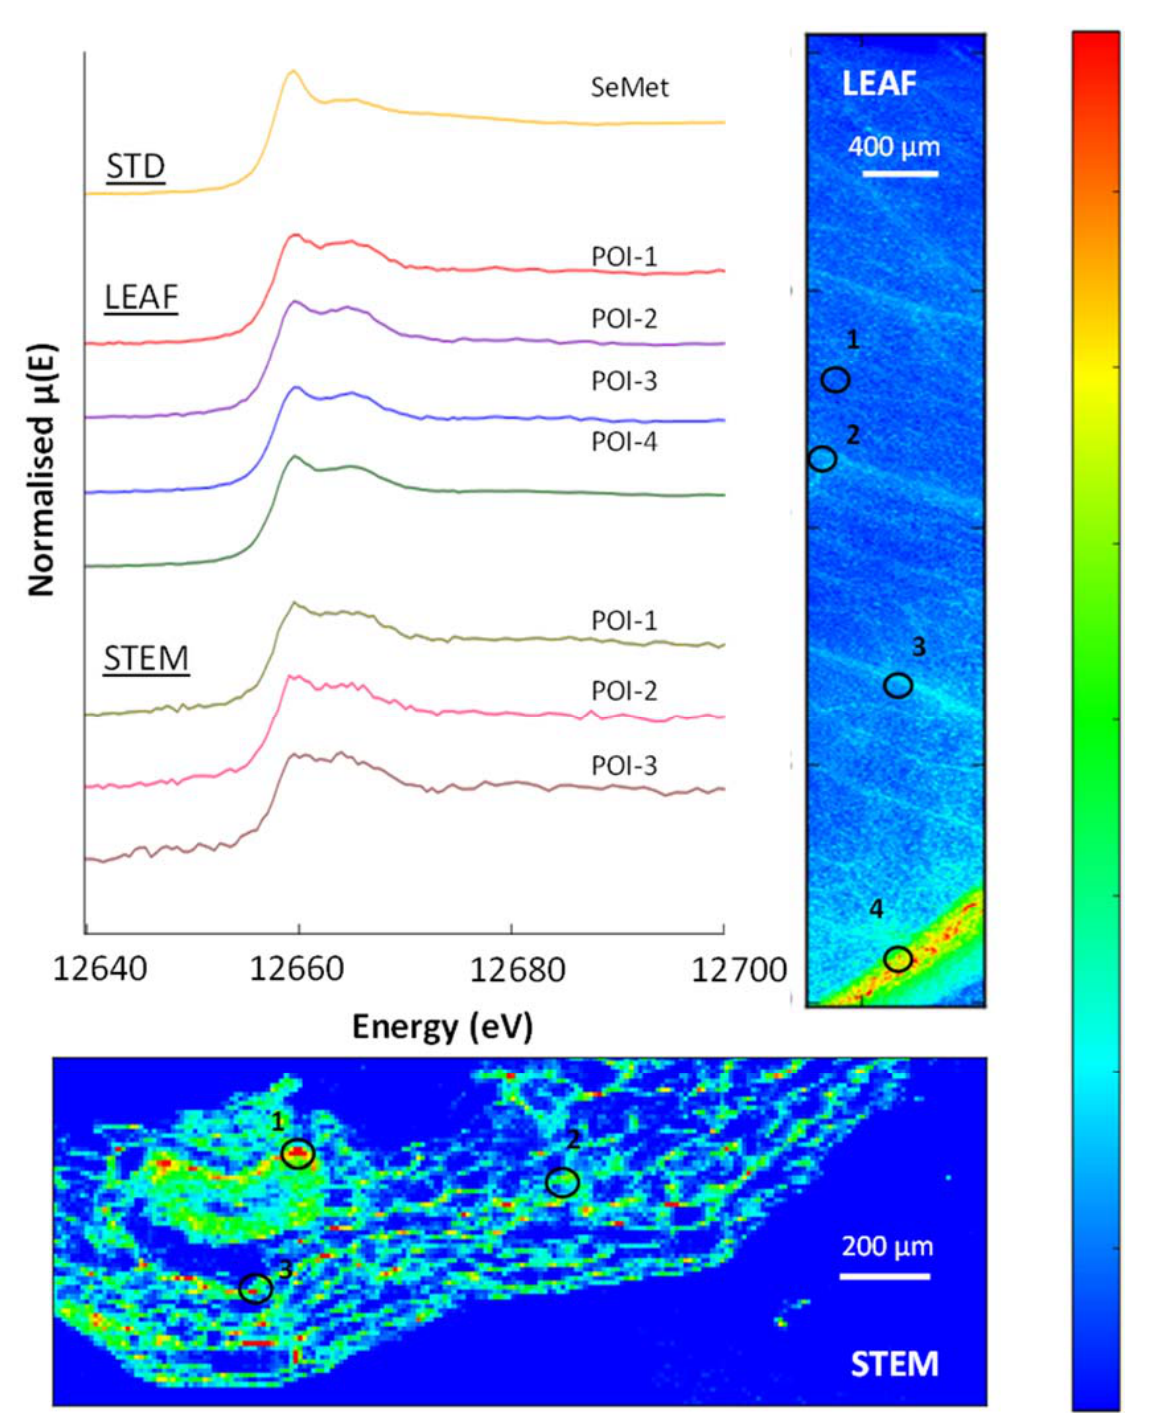
Figure 8. µ -XRF Se K -edge maps showing a white clover leaf and a cross-section through a stem and Figure 8. μ ‐ XRF Se K ‐ edge maps showing a white clover leaf and a cross ‐ section through a stem and a leaf from the vein out towards the margin. The µ -XRF is on a pseudo-temperature scale, with high a leaf from the vein out towards the margin. The μ ‐ XRF is on a pseudo ‐ temperature scale, with high selenium counts in red and areas with no counts in dark blue. ( Top left ): normalised XANES spectra selenium counts in red and areas with no counts in dark blue. Top left: normalised XANES spectra showing selenium species in selected POIs and the SeMet showing selenium species in selected POIs and the SeMet standard.